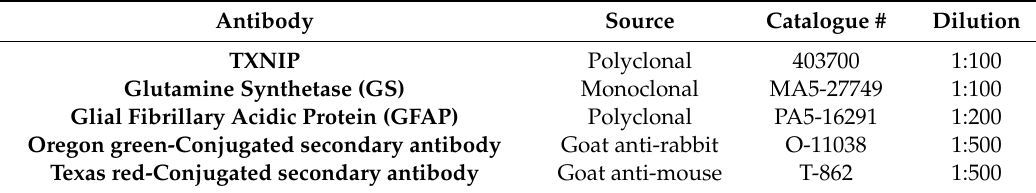
Table 3. List of antibodies and sources used to detect protein expression by Immunohistochemistry. Antibody